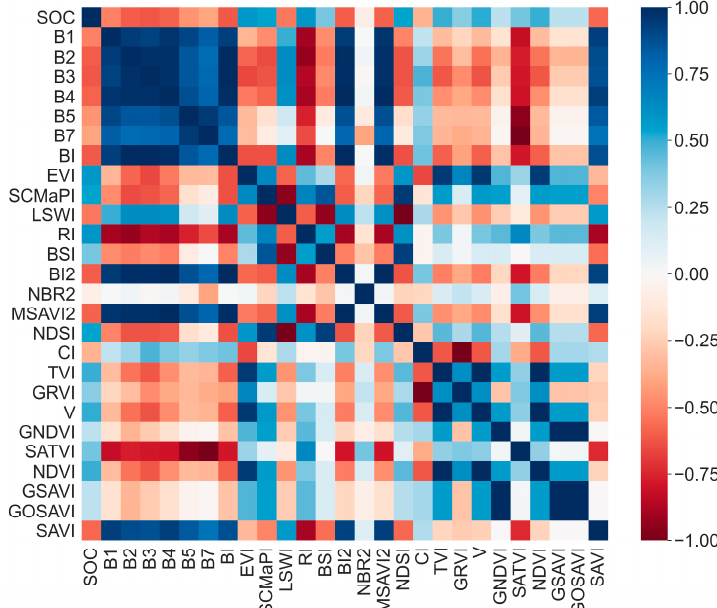
Figure 6. The correlation matrix (Pearson’s correlation) between the reflectances, the indices and the modeling variable SOC. The definition of significant features for SOC modeling and further independent features for the RI_sel dataset are based on the correlations (the hypothesis test by the p -values showed for all significant feature combinations a correlation close or equal to zero).